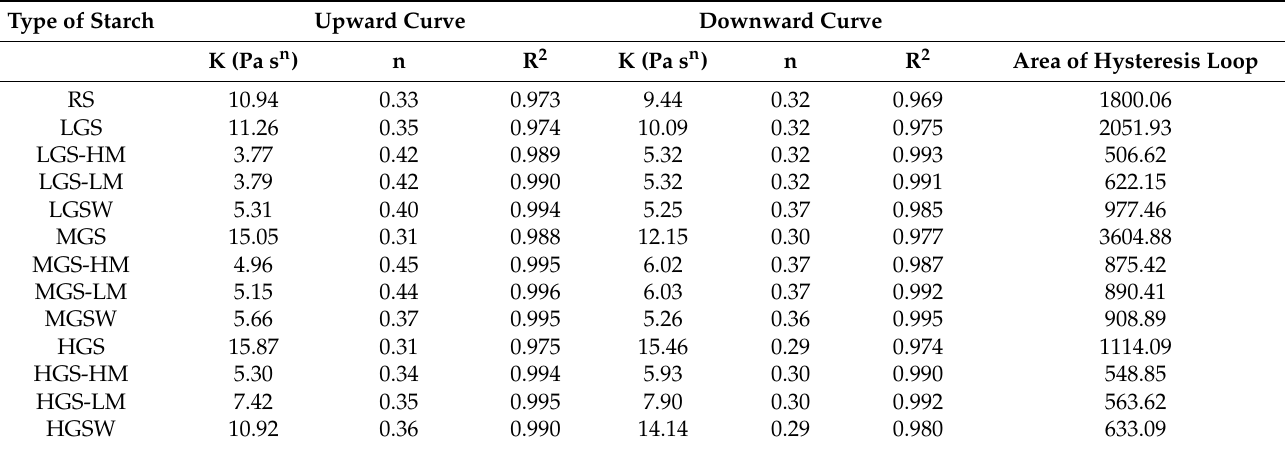
Table 3. The power law fitting parameters of starch pastes with different DSG reheated by different methods 1